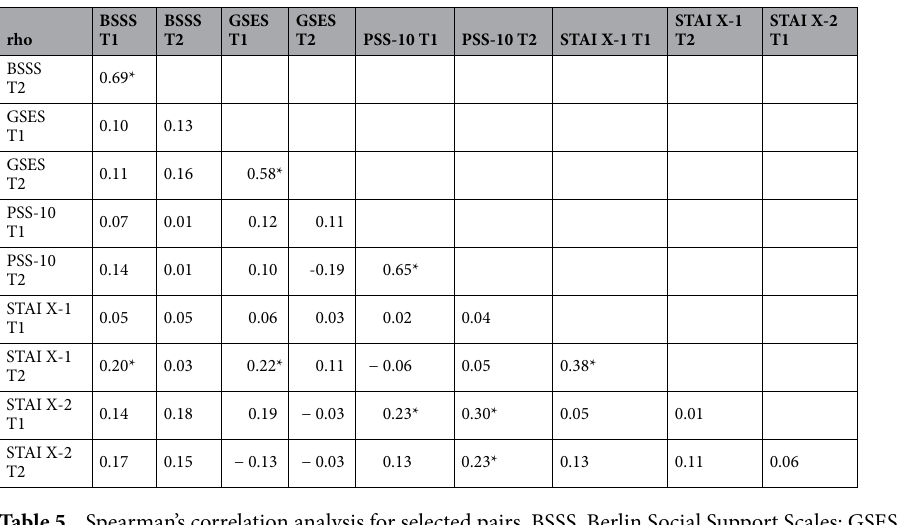
Table 5. Spearman’s correlation analysis for selected pairs. BSSS, Berlin Social Support Scales; GSES, General Self Efficacy Scale; PSS-10, Perceived Stress Scale; STAI X-1, The State-Trait Anxiety Inventory as a state; STAI X-2, The State-Trait Anxiety Inventory as a trait; T1, Initial results; T2, Final results; rho—Spearman’s correlation coefficient; *p <